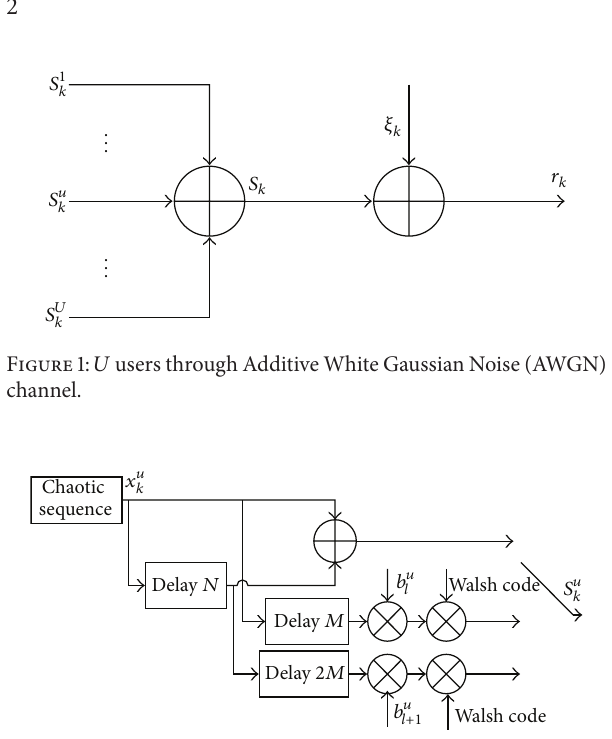
Figure 2: Transmitting end of user 𝑢 .